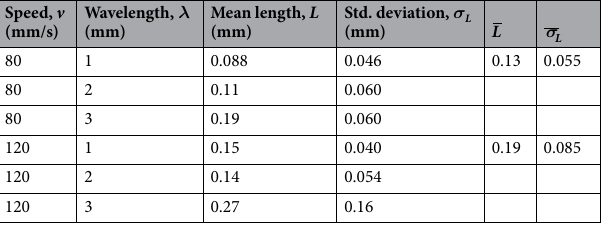
Table 1. We employed a standard method of quantifying signal similarity via joint recurrence plots (JRP), based on the statistics of line lengths L , yielded higher mean values at higher speeds v and larger wavelengths λ , and reflecting the typically greater similarity between measured and modeled force production at higher speeds and longer